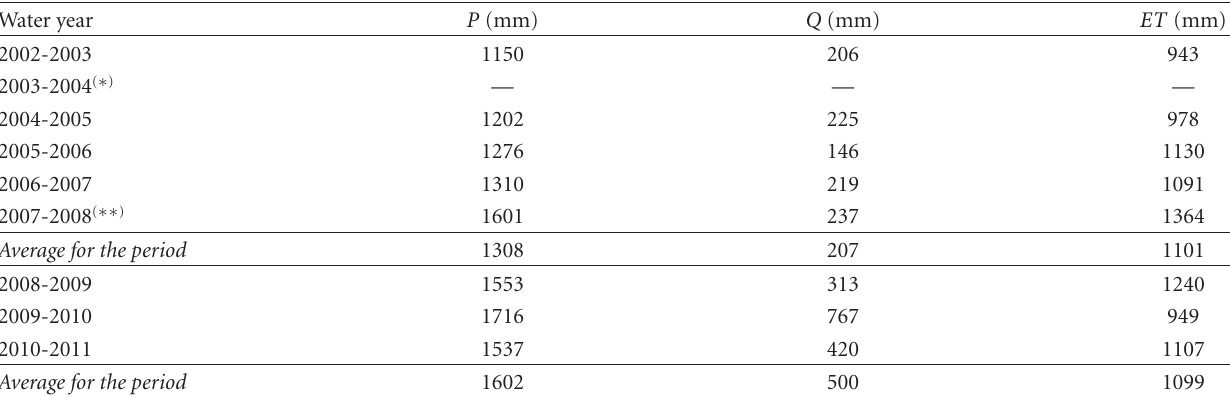
Table 3: Comparative results of the measurements of the study catchment water balance between the former Eucalyptus plantation precipitation. Q : annual water yield. ET : catchment scale